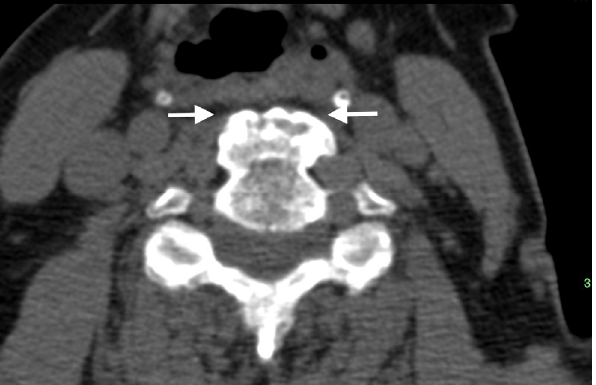
Figure 3. Axial CT image of a thick anterior osteophyte in the cervical spine of a patient with DISH that is impinging and causing narrowing of the adjacent esophagus (arrows).